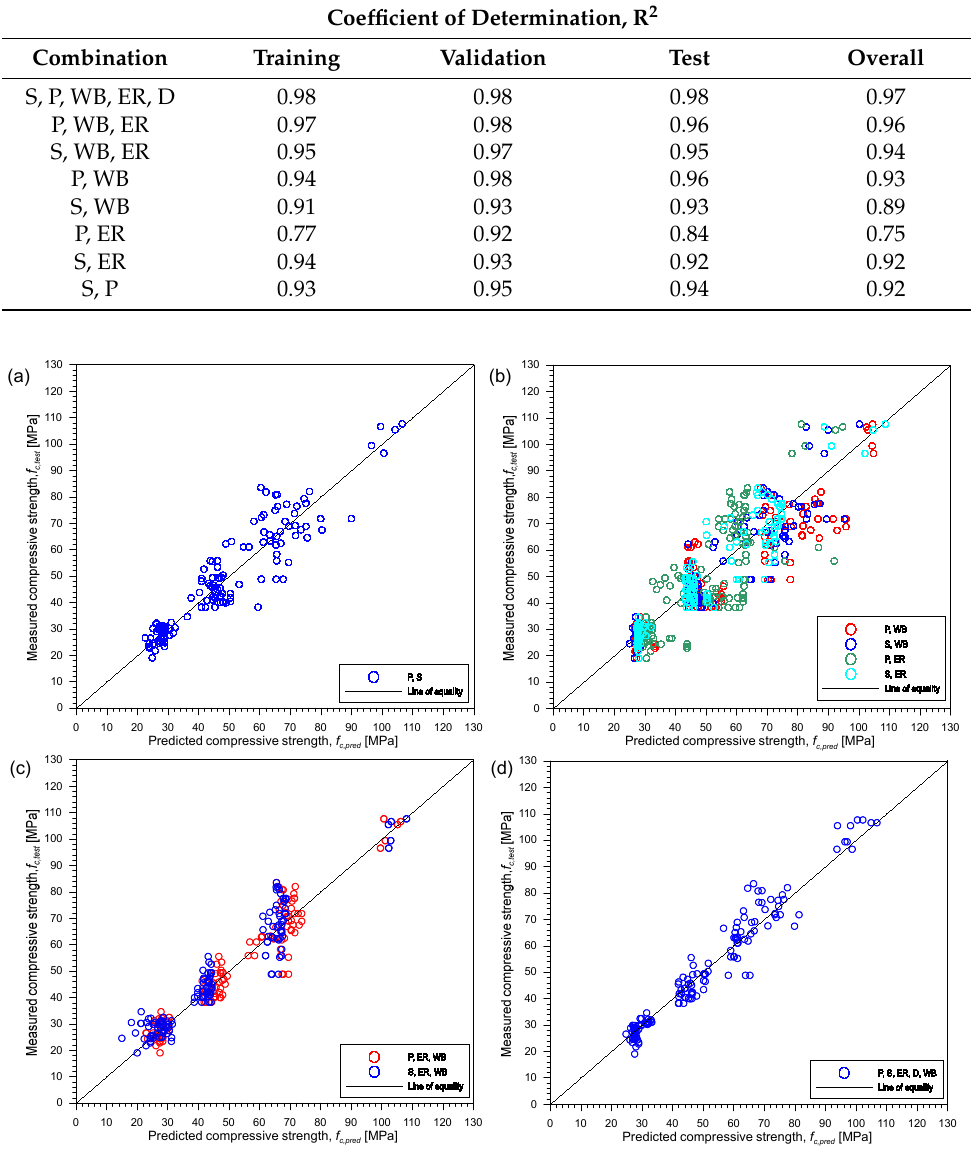
Figure 9. Correlation between actual f c,test and predicted f c,pred using different combinations of the five parameters from ANN analysis. ( a ) only UPV parameters: P, S, or P and S, ( b ) combination of UPV and one other parameter: P and WB, S and WB, P and ER or S and ER, ( c ) combination of UPV, ER and WB: P, ER and WB or S, ER and WB and ( d ) five all parameters: P, S, ER, D and WB. Note—S is S-wave velocity, P is P-wave velocity, ER is electric resistivity, D is density and WB is water-to-binder ratio.